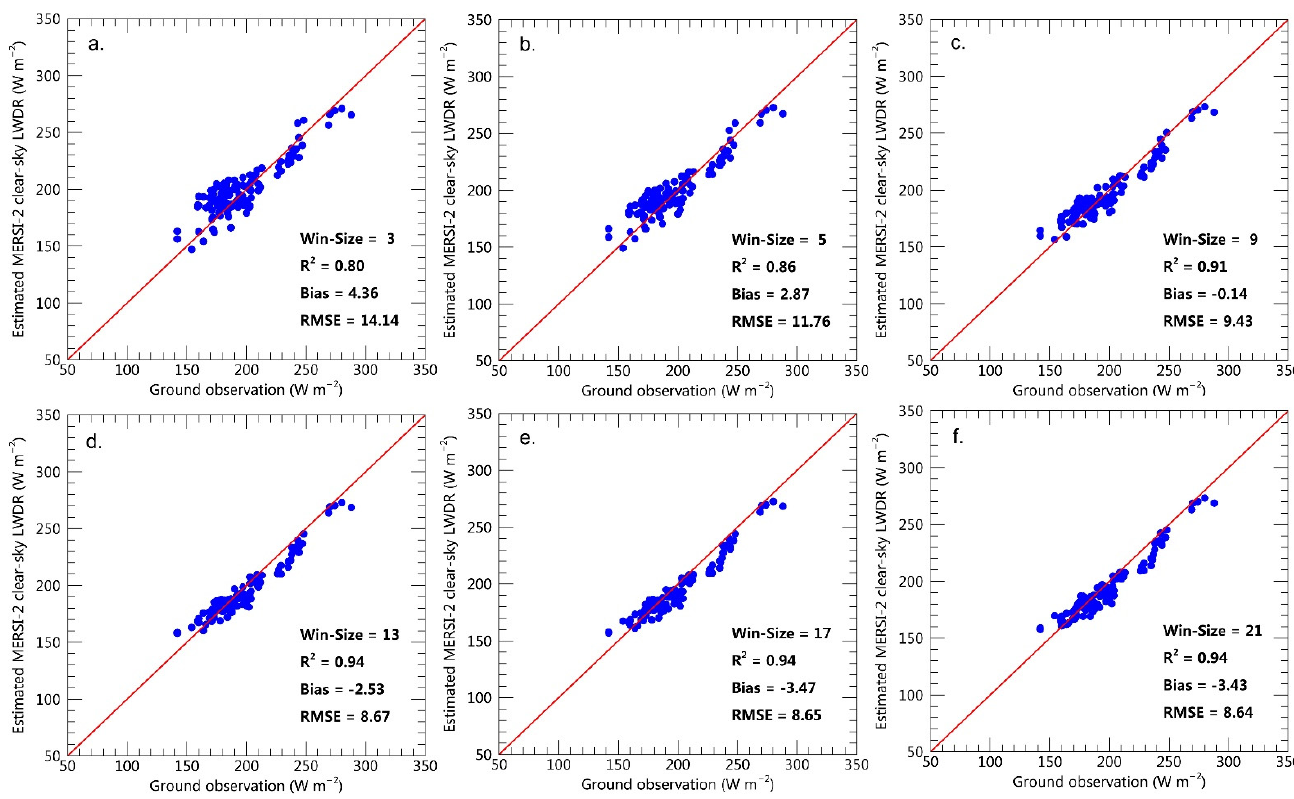
Figure 5. Correlations of the FY-3D MERSI-2 clear-sky instantaneous LWDR integrated at different window sizes to the BSRN ground measurements. ( a – f ) shows the validating results of the FY-3D MERSI-2 clear-sky LWDR at different window sizes (3 km, 5 km, 9 km, 13 km, 17 km, and 21 km, respectively). The red line is the 1:1 line. Table 5. Validation accuracies of the MERSI-2 clear-sky LWDR at different neighborhood window sizes with BSRN ground observations. The units of RMSE and bias metrics are W/m 2 .